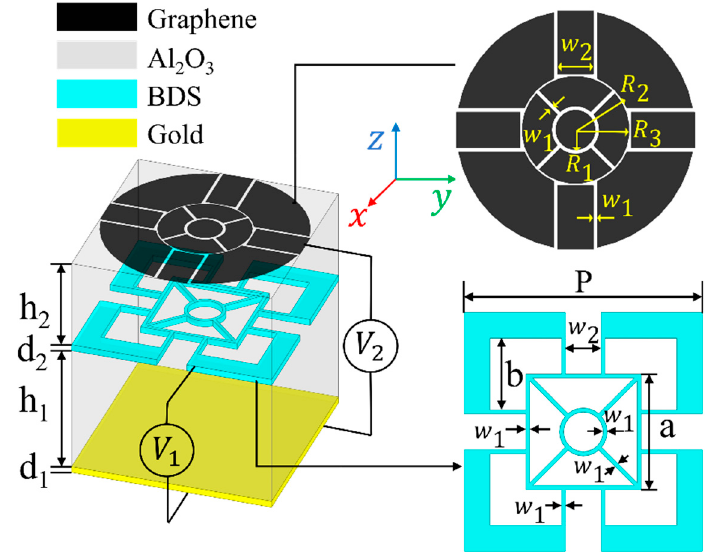
Figure 2. Schematic diagram of the proposed THz absorber. Table 1. Detailed dimensional parameters of the proposed absorber structure.